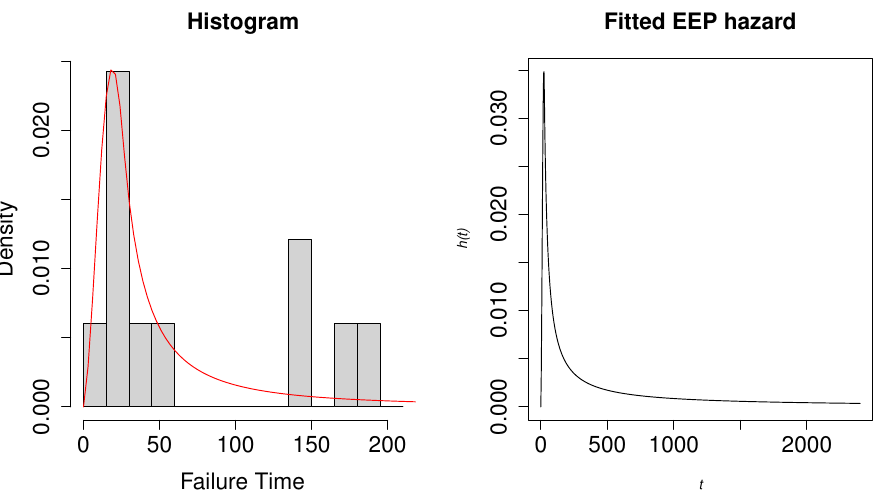
Figure 11. The fitted hazard function of EEP distribution for the time to electric breakdown data